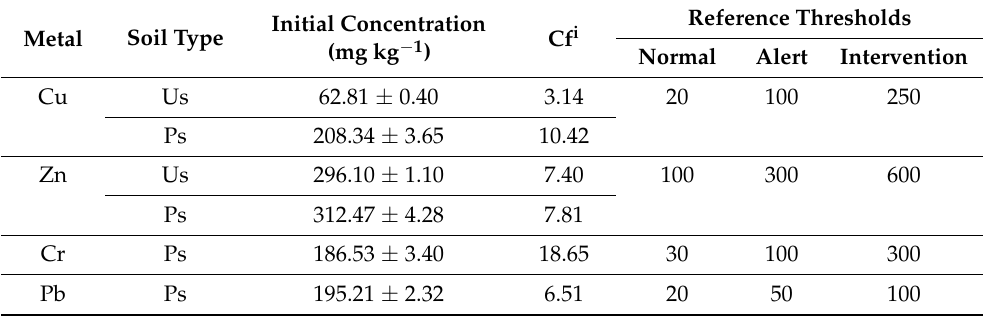
Table 1. Initial mean concentration of heavy metals in soil and reference thresholds.